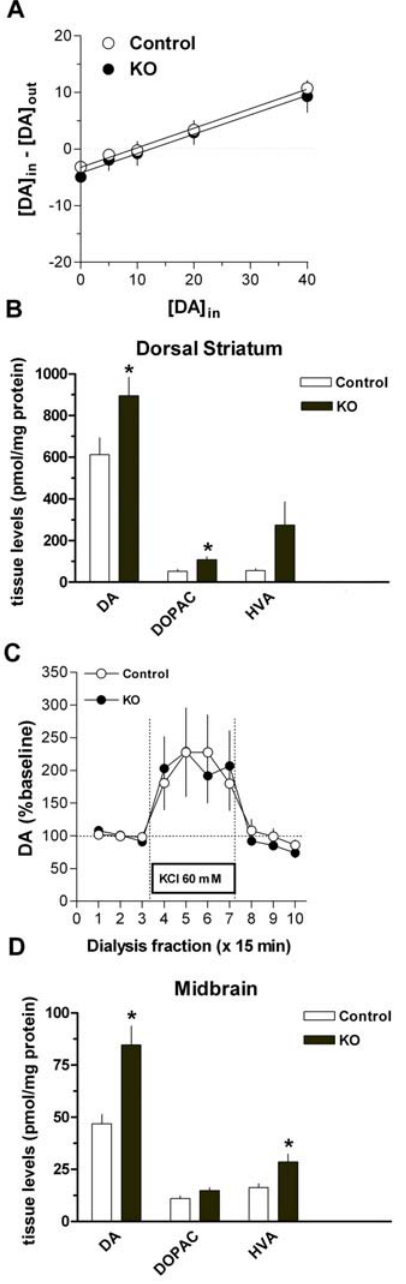
Figure 6. Selective Pten deletion in DA cells results in unaltered extracellular dopamine dynamics in spite of a significant increase in tissue catecholamine content. (A) Pten KO mice showed no differences in basal extracellular dopamine as estimated by the x-intercept in the no net flux analysis. DA clearance was also unaltered as indicated by no change in the extraction fraction (slope of the no net flux regression line). (C) Depolarization evoked dopamine release was unaltered in Pten KO animals. The total tissue content of dopamine (DA) was increased in the dorsal striatum (B) and the midbrain (D) of Pten KO mice. Levels for the dopamine metablites DOPAC (dihydroxyphenylacetic acid), and HVA (homovanillic acid) were significantly inceased in the striatum and midbrain respectively. 3MT (3- methoxytyramine) levels remained unchanged as compared to controls. All data are mean 6 SEM. *p , 0.05, Student’s t-test.